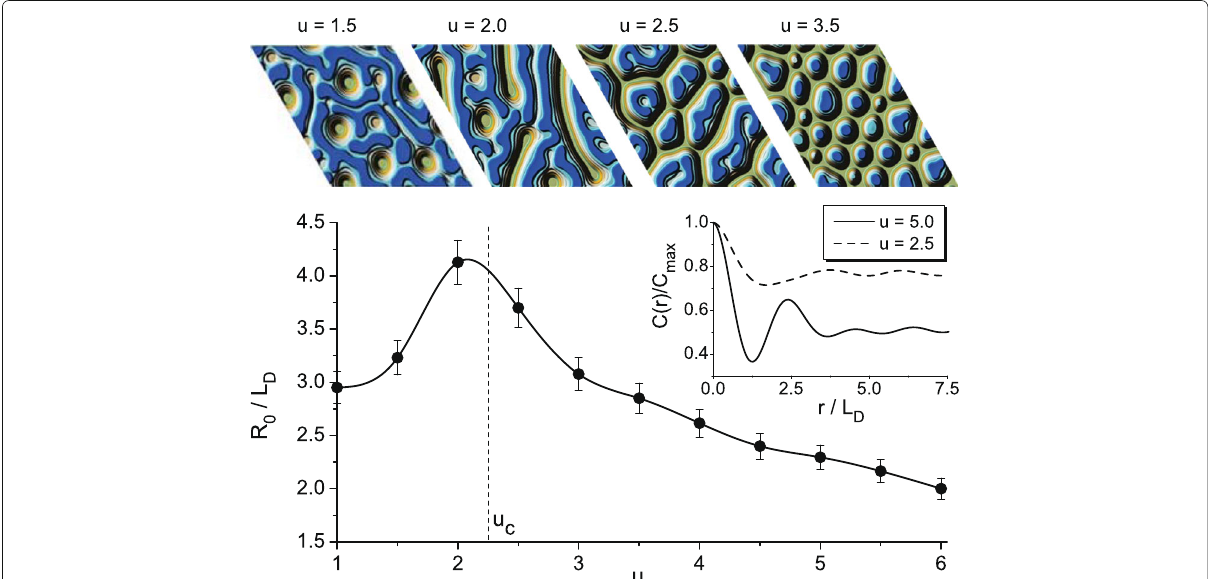
Fig. 2 Dependence of the mean distance between structures R 0 versus anisotropy strength. Snapshots in the stationary limit at different values of the anisotropy strength u are shown in the toppanel . The corresponding stationary two-point correlation functions at different values of the anisotropy strength u are shown in insertion